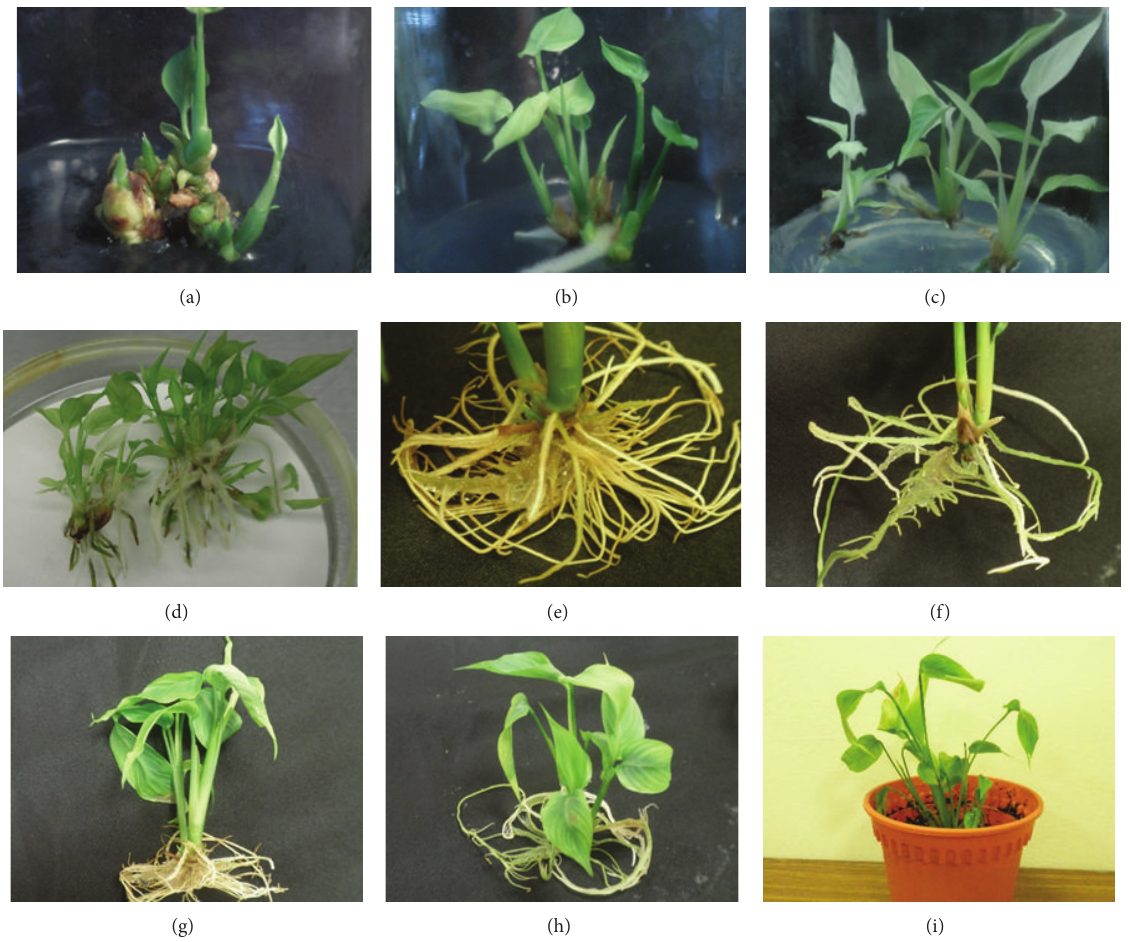
Figure 4: Development of high quality plantlet from shoot bud explants of Calathea crotalifera on multiplication media (MS medium with 3.5 mg/L BAP and 1.0mg/L NAA) and rooting media (MS medium with 1.0 mg/L NAA). (a) Induction of microshoots from incised shoot bud explants. (b) High quality plantlets with dark green leaves in multiplication medium supplemented with 1g/L activated charcoal. (c) Plantlets with light green leaves without necrosis problem on multiplication medium supplemented with 1g/L L-glutamine. (d) Plantlets with high multiple shoots induction. (e) Induction of healthy root in rooting media supplemented with 1.0mg/L NAA. (f) Roots induction on rooting media supplemented with 1.0 mg/L IBA. (g) and (h) Healthy plantlets ready to be acclimatized. (i) Development of successfully acclimatized